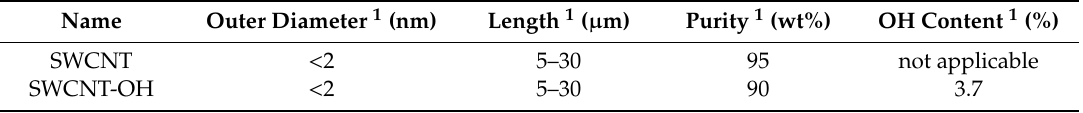
Table 1. Properties of carbon nanotubes.